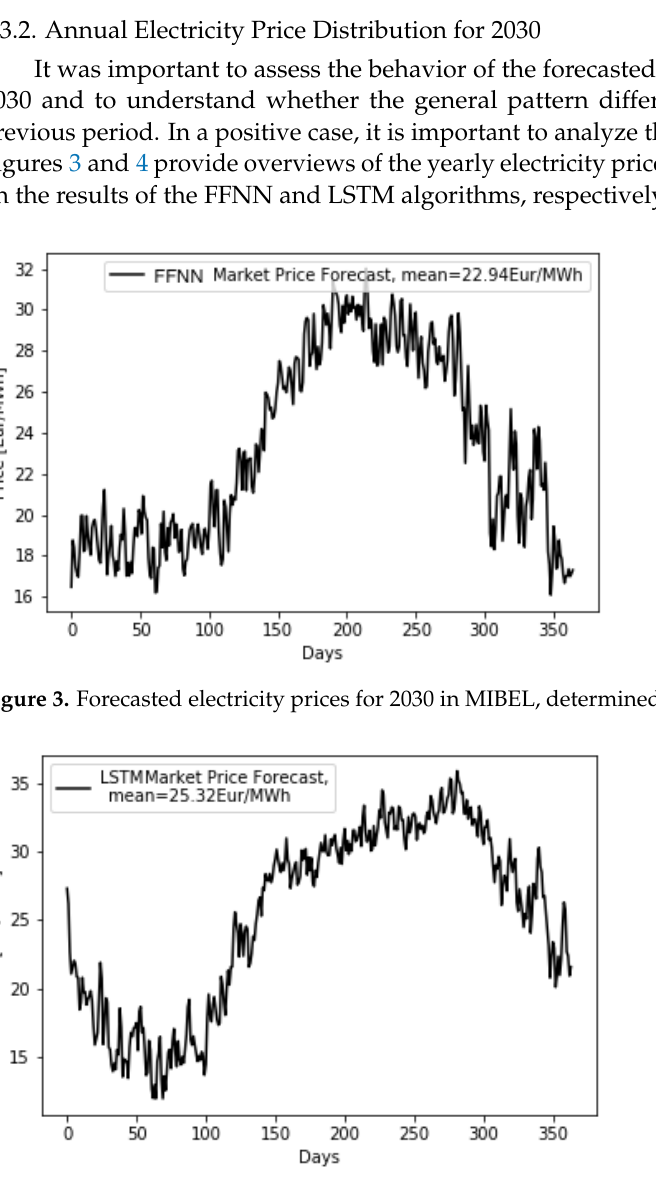
Figure 5. Eeal electricity prices in MIBEL for 2019 and the yearly average price.